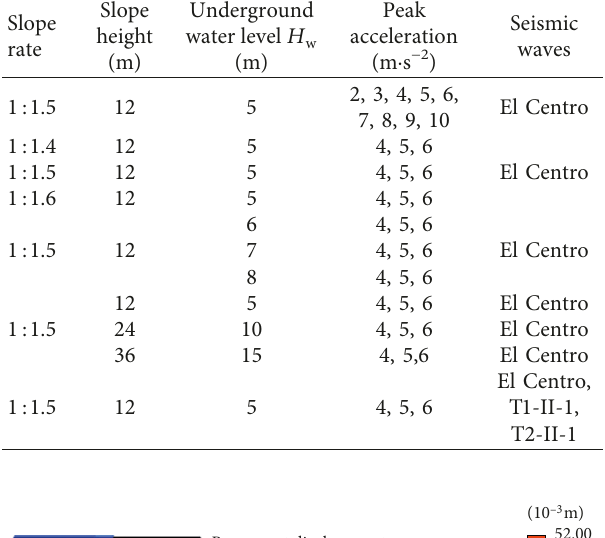
Table 4: Numerical procedure.